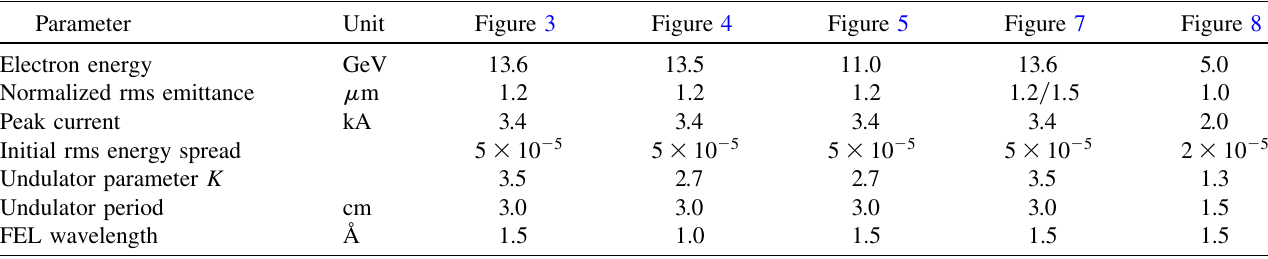
TABLE I. Main simulation parameters for optical klystron x-ray FELs.